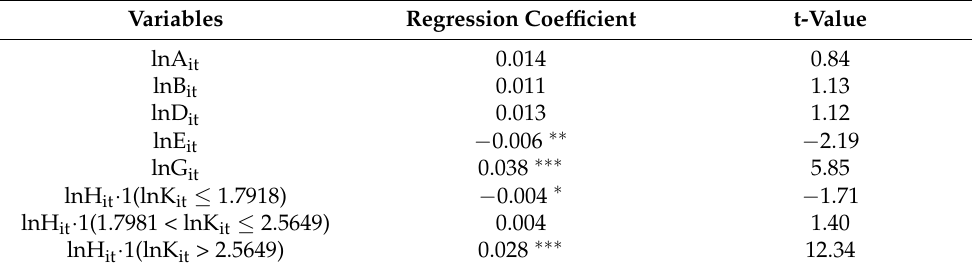
Table 7. Results of estimating parameters of the panel threshold